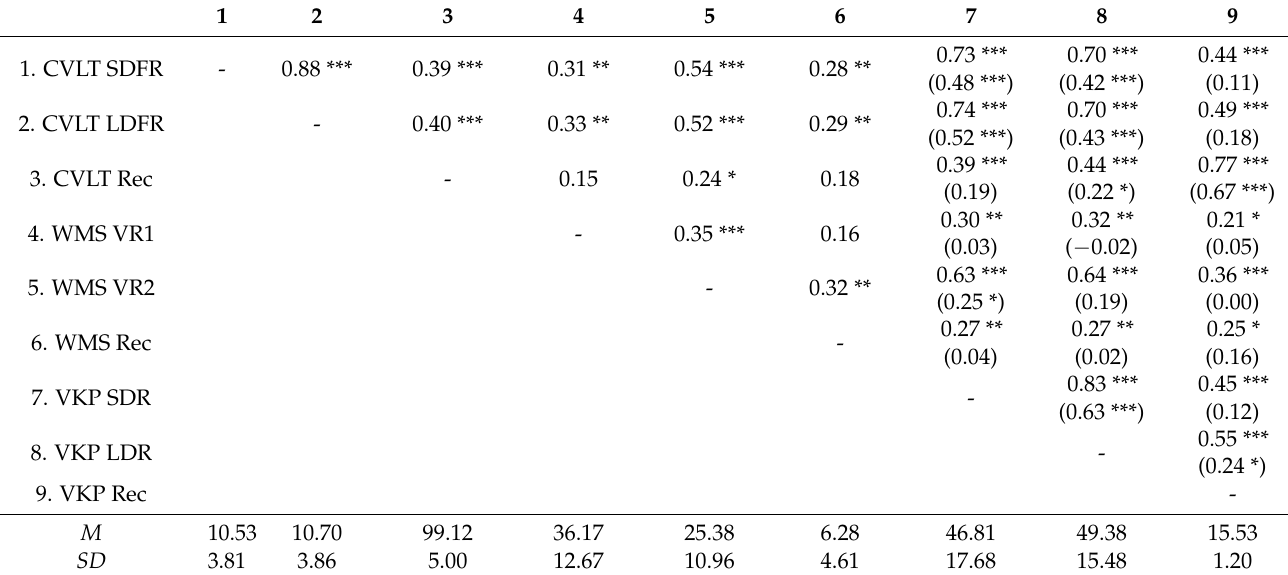
Table 2. Bivariate correlations between and descriptive statistics for all variables of interest among all participants ( n =